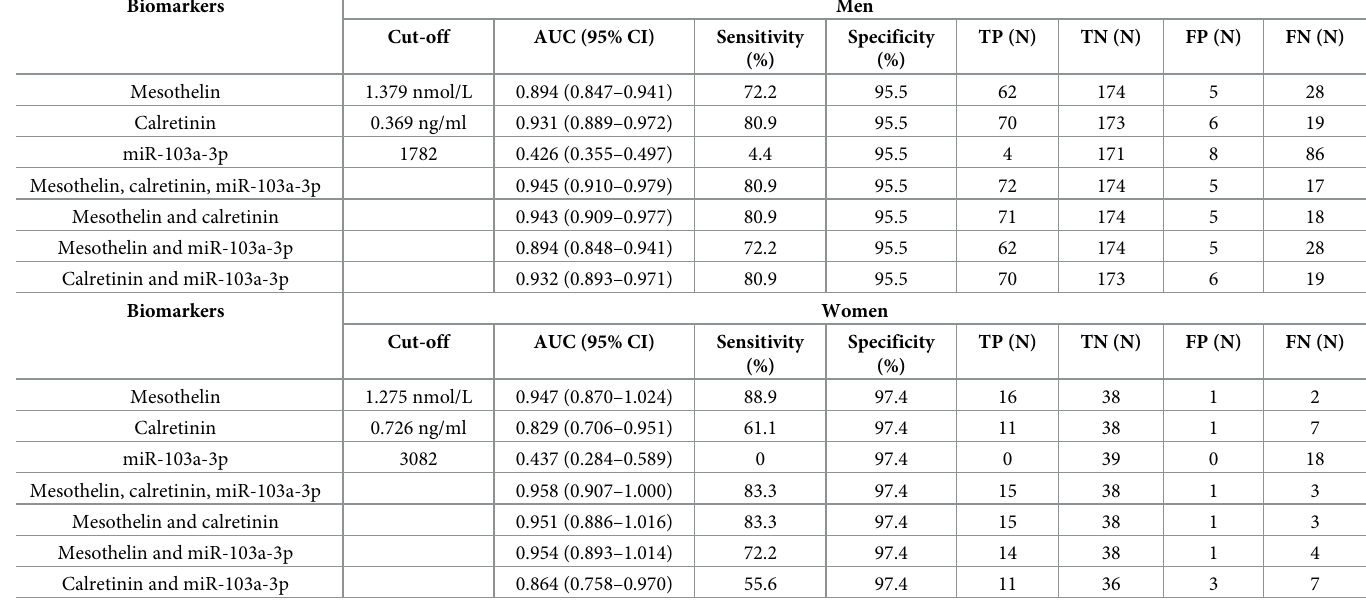
Table 3. Sensitivity and specificity of biomarkers among malignant pleural mesothelioma cases and population controls according to sex groups in a Mexican population.